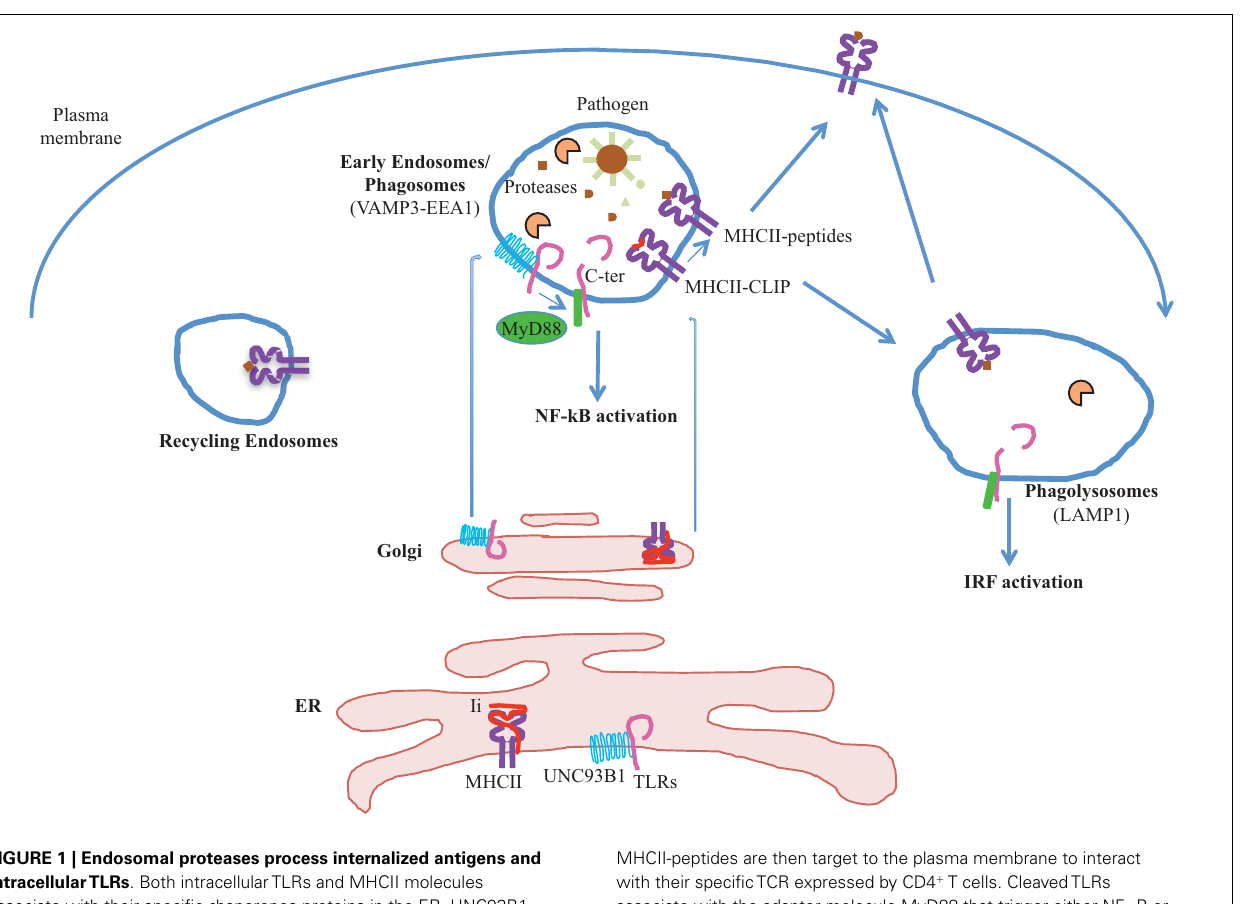
FIGURE 1 | Endosomal proteases process internalized antigens and intracellularTLRs . Both intracellularTLRs and MHCII molecules associate with their specific chaperones proteins in the ER, UNC93B1, and Ii chains respectively, and traffic toward the endosomes. In the endosomes,TLRs, Ii chain, and exogenous antigens are cleaved by proteases. Peptides are loaded on MHCII molecules and the complexes